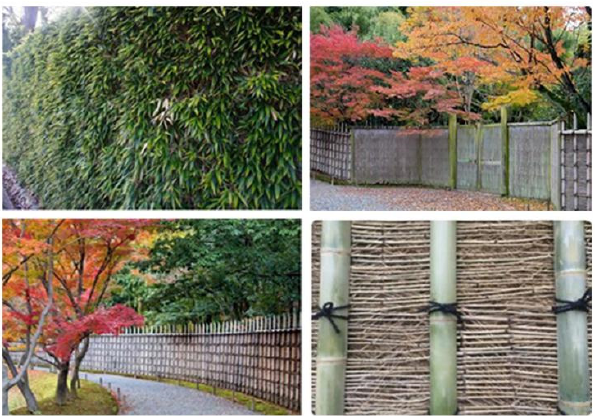
Figure 7. Katsura Imperial Villa’s bamboo wall (source: online: https://image.baidu.com/search/index?tn=baiduimage&ps=1&ct=201326592&lm=-1&cl=2&nc=1&ie=utf-8&dyTabStr=MCwzLDcsMiw2LDQsMSw1LDgsOQ%3D%3D&word=%E6%A1%82%E7%A6%BB%E5%AE%AB accessed on 22 June 2022).